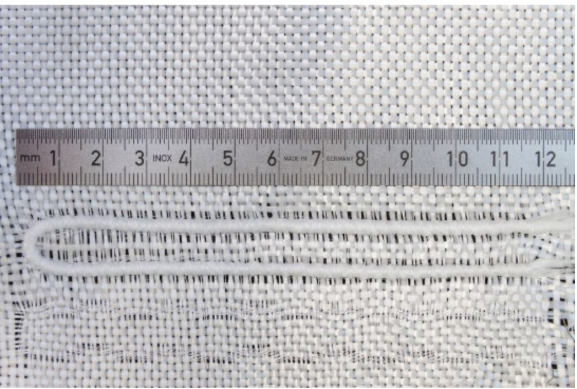
Figure 1. Polypropylene-glass fiber braided SMA wire loop integrated onto the glass fiber